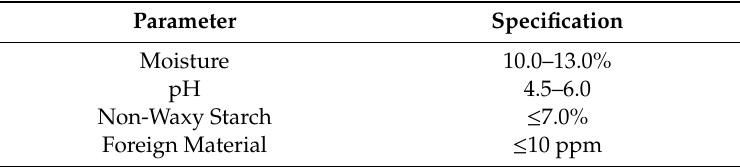
Table 1. Properties of the waxy corn starch used in this study 1